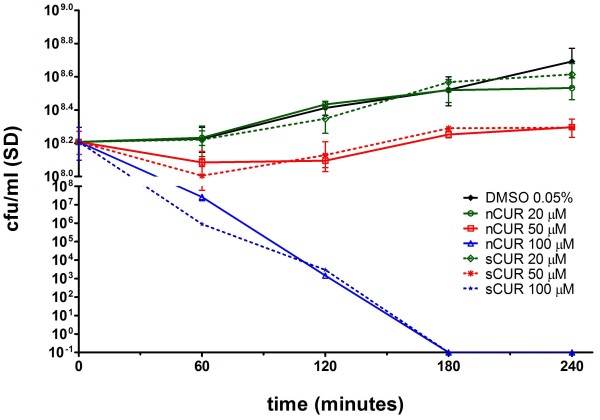
Bactericidal effects of nCUR versus sCUR. Comparative quantitative time-kill analysis of nCUR versus sCUR for M. catarrhalis strain O35E. Quantitative cultures were obtained at 0, 60, 120, 180, and 240 minutes. Killing kinetics were similar for both nCUR and sCUR at all concentrations tested (20, 50, and 100 μM). The negative control medium consisted of BHI containing 0.05% DMSO.